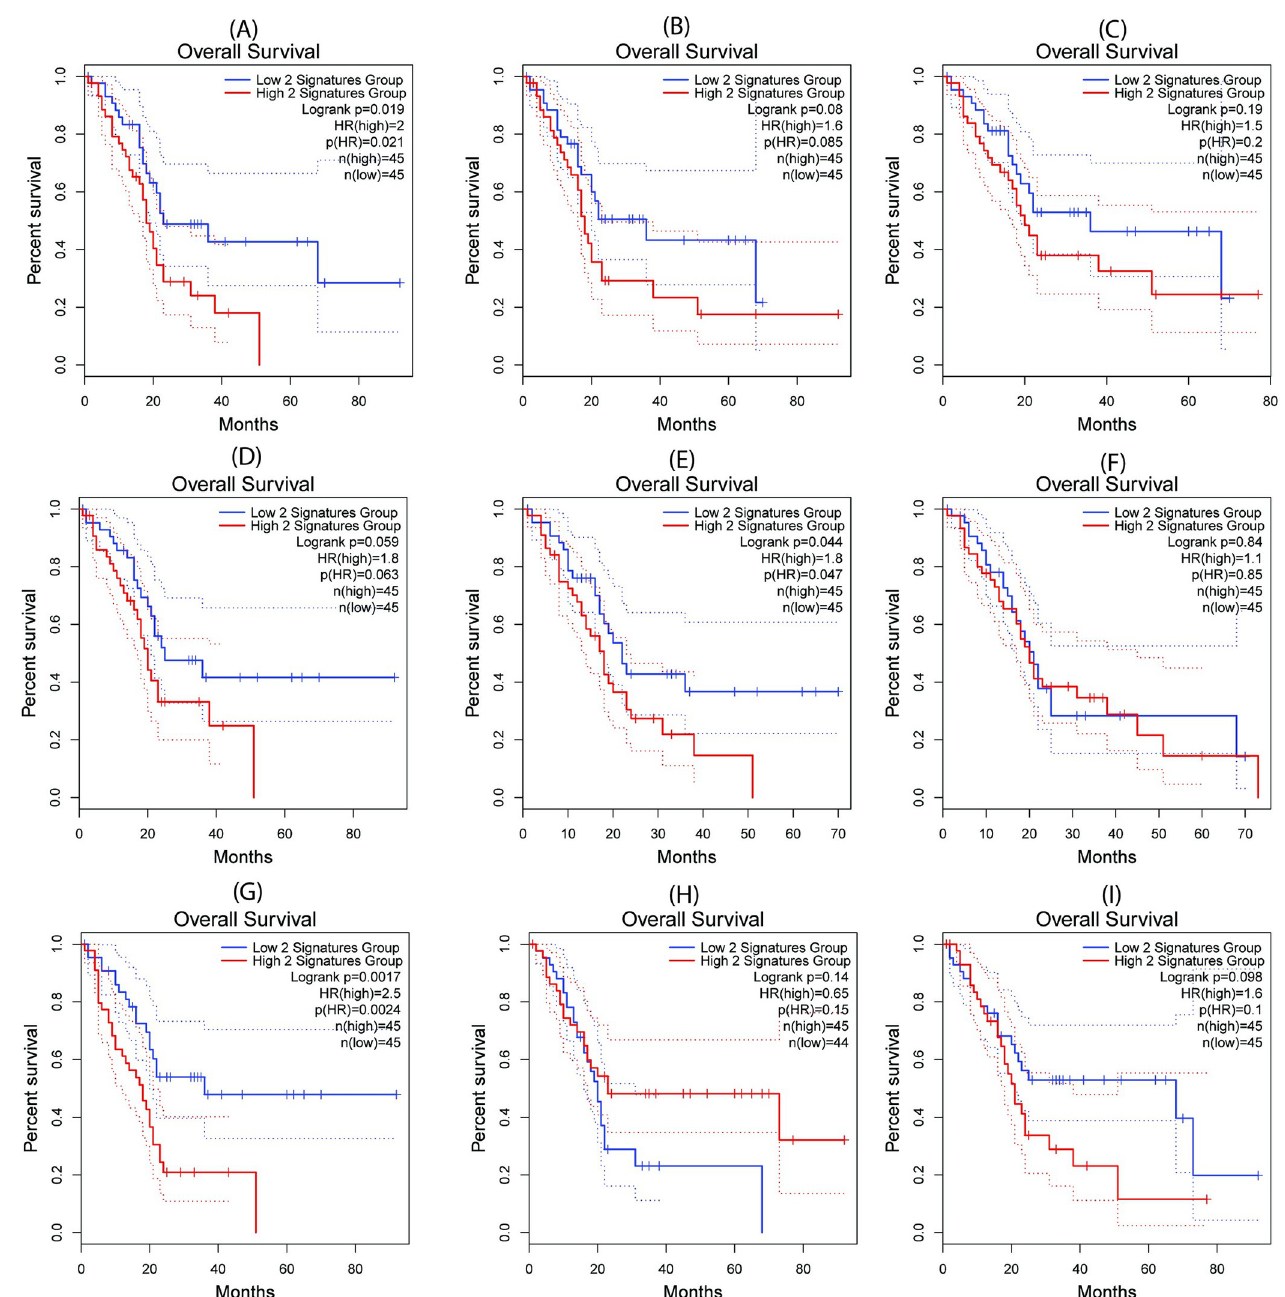
Fig 5. Kaplan-Meier curves for the nine top-ranked target combinations (a)-(i). Kaplan-Meier curves and other survival statistics for (a) < EGLN1, TRFC > , (b) < MAP2K2, TRFC > , (c) < HPSE, TRFC > , (d) < PPIC, TRFC > , (e) < FRK, TRFC > , (f) < EGLN1, COX7C > , (g) < XDH, TRFC > , (h) < MAP2K2, COX7C > , and (i) < FTL, TRFC > . Y-axis indicates survival probability while X-axis indicates months. The blue line in each plot indicates low expression of the two gene groups, and the red line, high